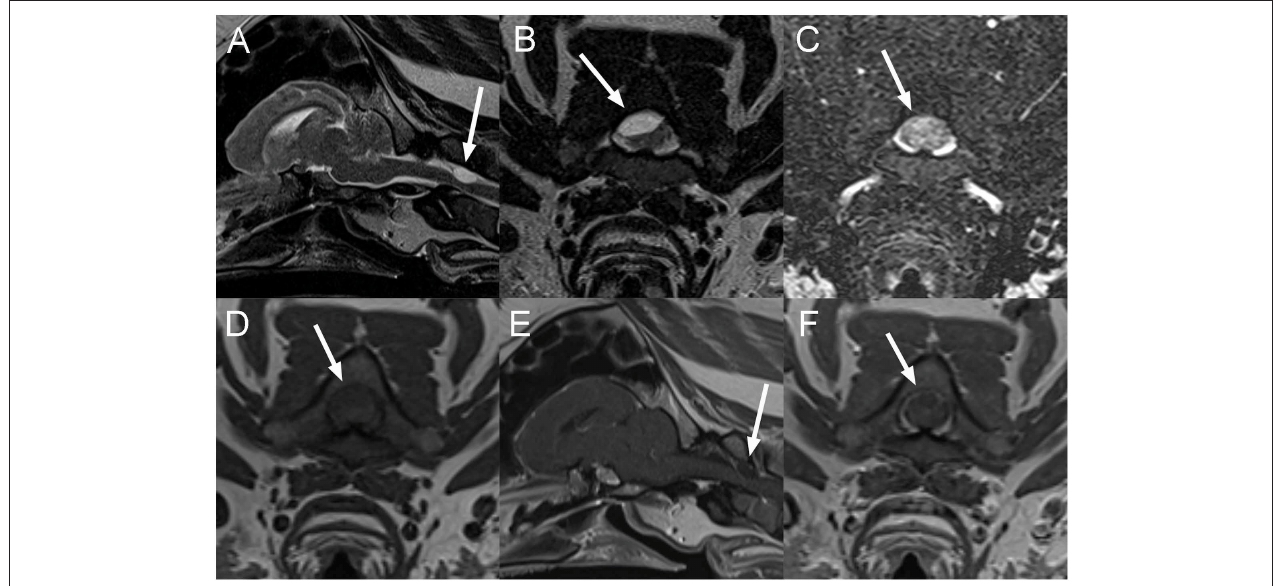
FIGURE 4 | Sagittal T2W (A) , transverse T2W (B) , T2-Fluid attenuation inversion recovery (FLAIR) (C) , T1W (D) , and sagittal (E) , and transverse (F) post contrast T1W images of the head and cranial cervical vertebral column in a 10-year-old pig presented with progressive deficits attributable to a brainstem or cervical spinal cord lesion (Case 4). There is a T2W hyperintense well-circumscribed ovoid mass lesion associated with the right dorsal aspect of the vertebral canal, resulting in marked displacement and compression of the spinal cord from right dorsal (A,B) . The lesion remains mildly hyperintense on T2-FLAIR (C) and is hypointense to the spinal cord on T1W images (D) with very faint linear peripheral contrast enhancement adjacent to the lesion (E,F) . The lesion is indicated by arrows on all images. An extradural cyst-like lesion containing cellular or proteinaceous fluid was considered most